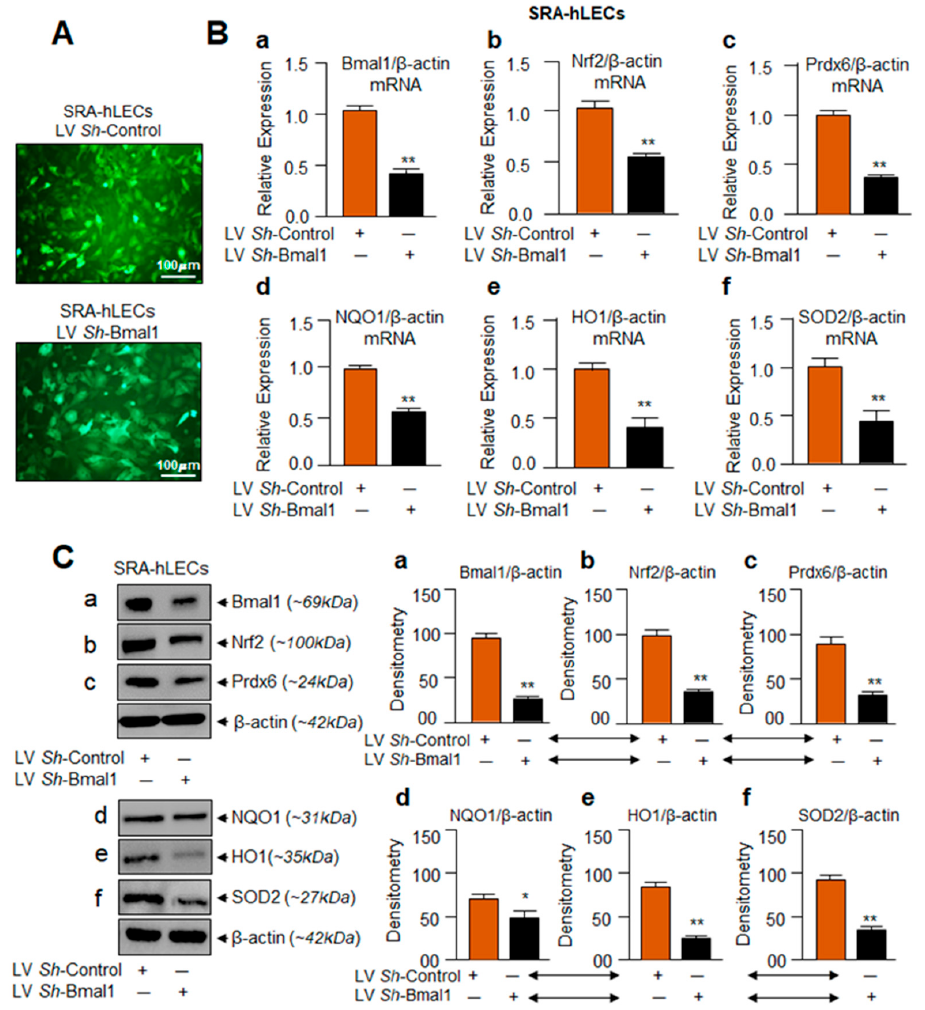
Figure 3. Similar to Aging hLECs, Nrf2 / ARE antioxidant targets were disrupted with Bmal1-depletion. ( A ) Photomicrograph representing stably infected SRA-hLECs with Control (lentiviral (LV) Sh -Control) or sh RNA specific to Bmal1 (LV Sh -Bmal1) lentiviral (LV). Upper panel: LV Sh -Control; Lower Panel: LV Sh -Bmal1. ( B , C ) Bmal1 knockdown (a) significantly reduced Nrf2 (b), Prdx6 (c), NQO1 (d), HO1 (e), and SOD2 (f) mRNA ( B ) and protein ( C ) expression. SRA-hLECs were infected with LV Sh -Control or LV-s h RNA specific to Bmal1 and selected with puromycin antibiotic as noted in the Materials and Methods section. Total RNA ( B ) and protein ( C ) were extracted from infectants and subjected to qPCR ( B ) and immunoblotting ( C ) using specific probes, as indicated. Protein blots were quantified using densitometer, and levels were normalized to corresponding β -actin bands value; histograms are shown in the right side of the protein bands. Data represent means ± S.D. of three independent experiments. LV Sh -Control (orange bar) vs. LV Sh -Bmal1 (black bar); * p < 0.05, ** p <